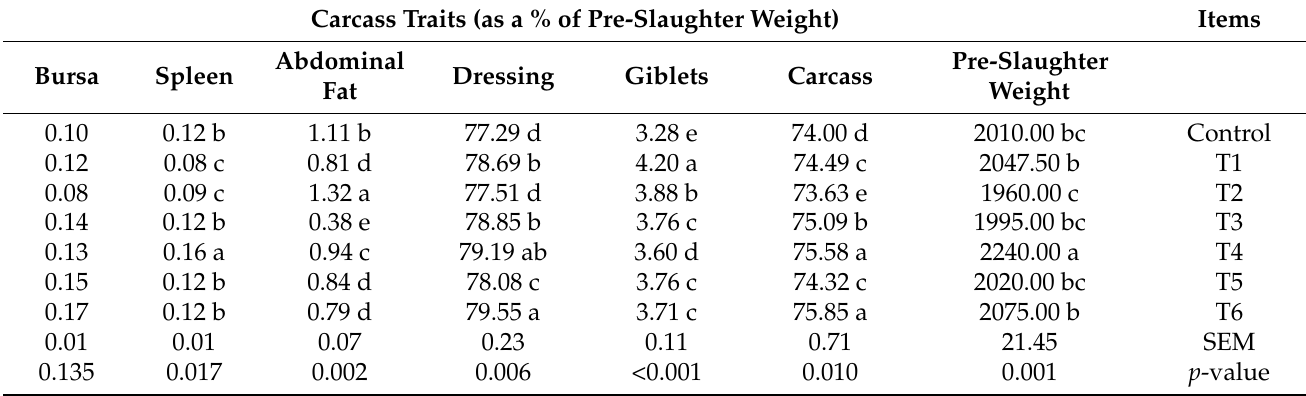
Table 4. Carcass traits (%) of broilers as affected by dietary supplementation of ZnNPs, CurNPs and Bl . ( n = 6). Carcass Traits (as a % of Pre-Slaughter Weight)